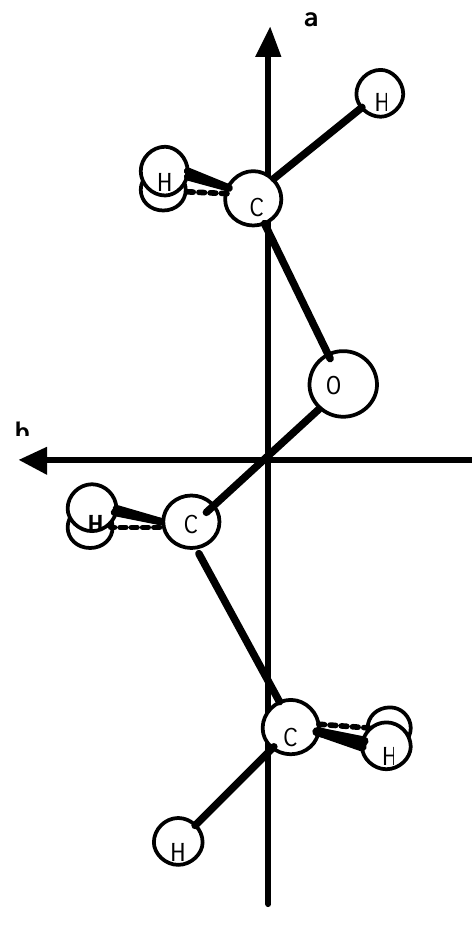
Figure 1 . Molecular Structure of C 2 H 5 OCH